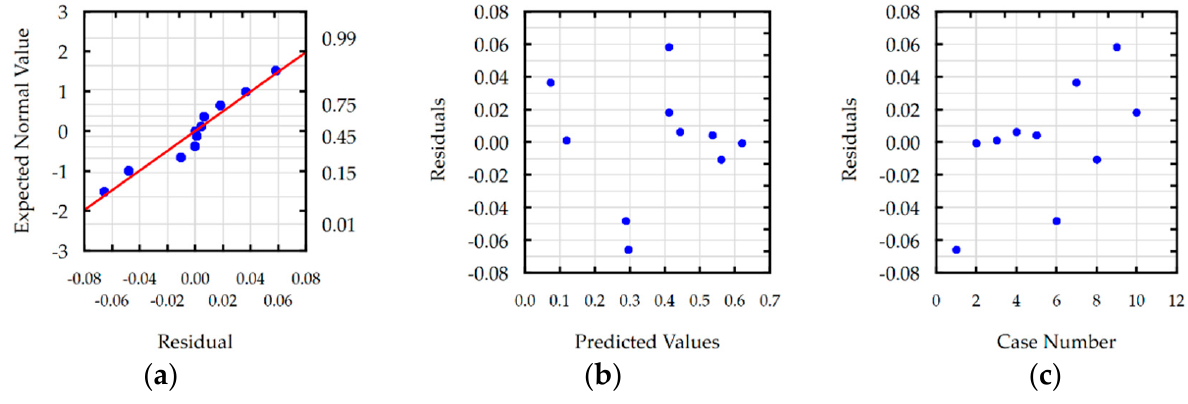
Figure 11. Plots for the model of TW: ( a ) the normal plot of residuals; ( b ) the residuals versus the predicted values; and ( c ) the residuals versus the case number.